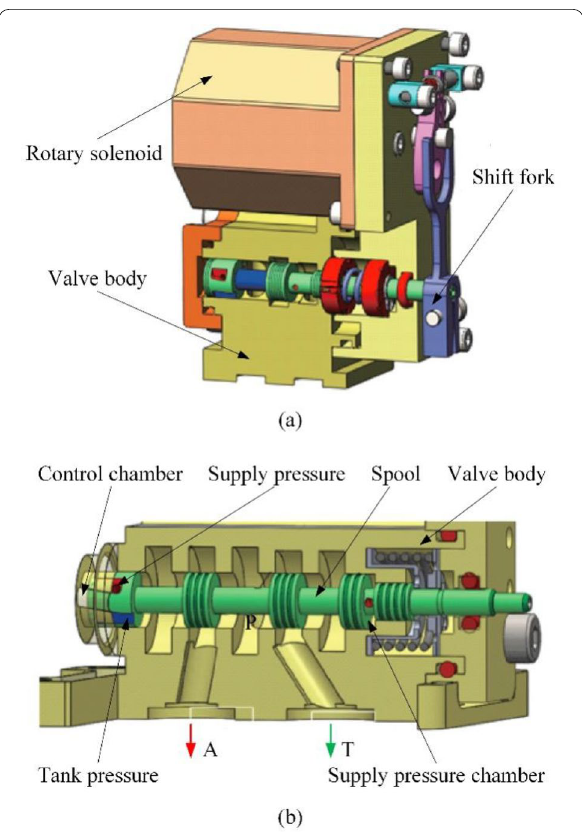
Figure 14 Two-dimensional valve proposed by Jia et al.: a valve structure, b details of the servo spiral